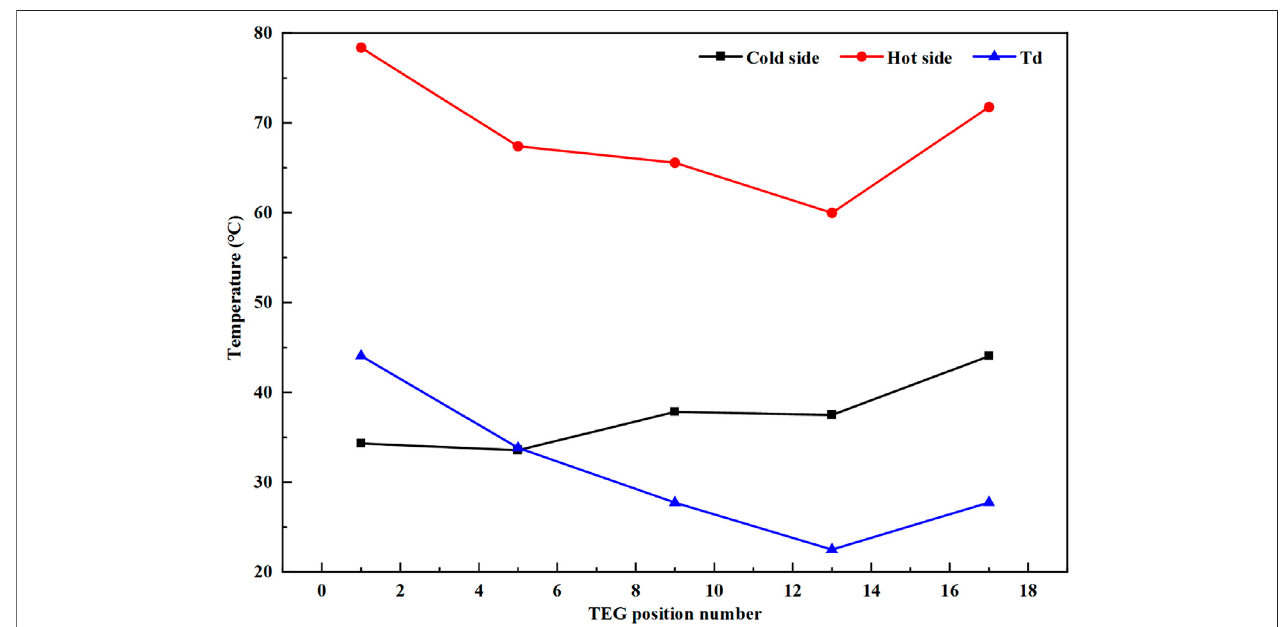
FIGURE 8 | Temperature curves with different